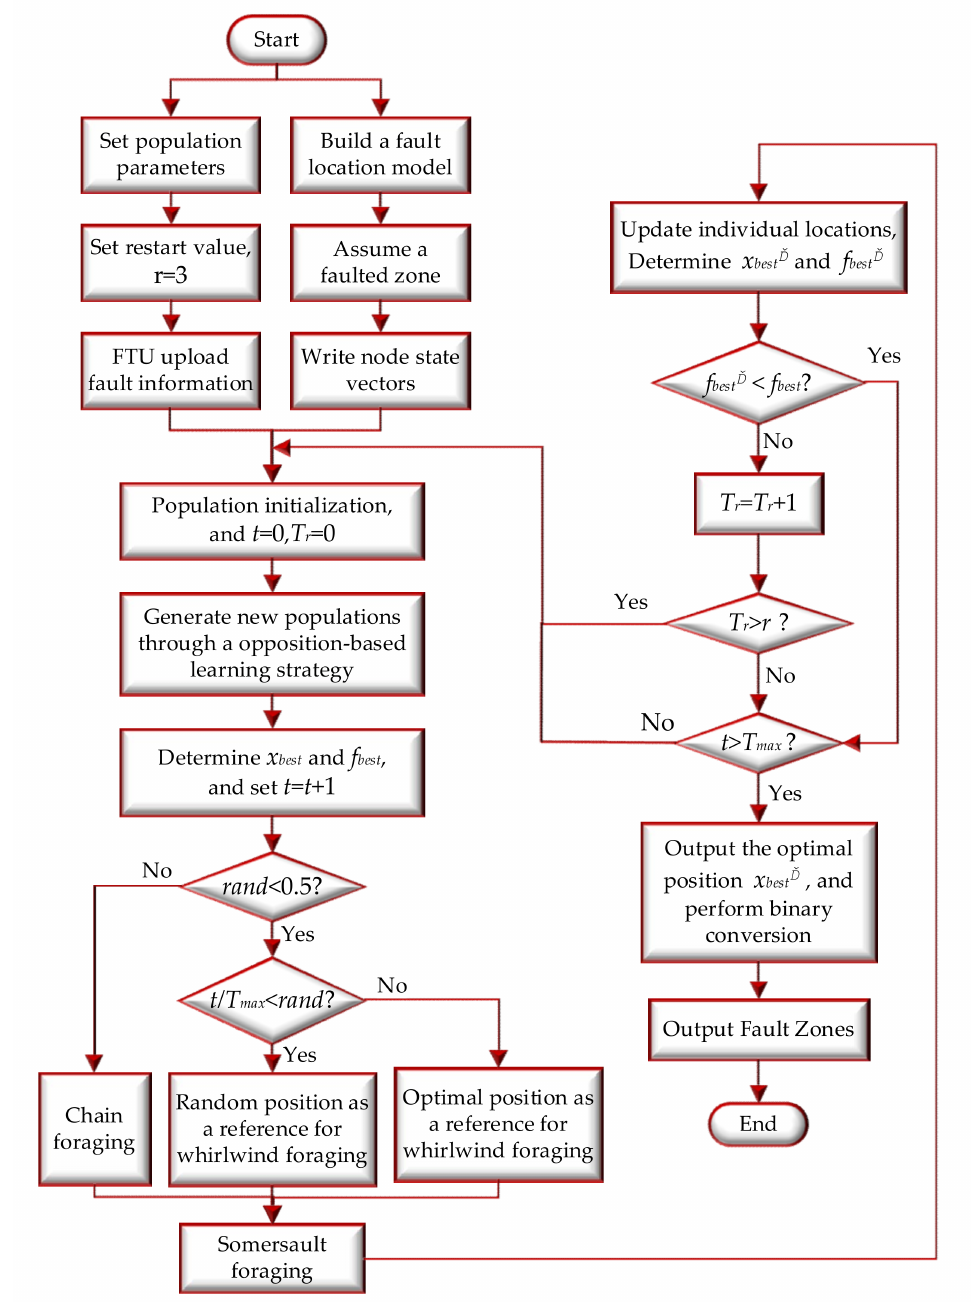
Figure 5. Flowchart of fault location based on